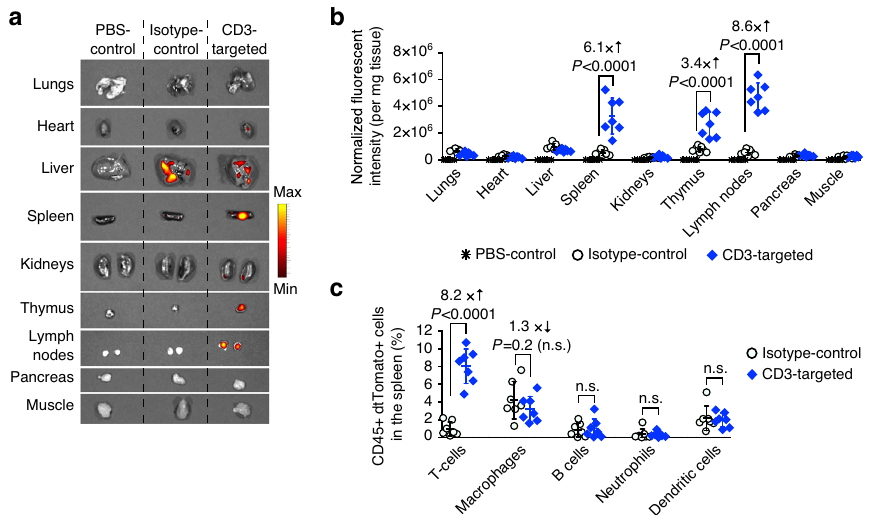
Fig. 5 Ef fi cient T-cell targeting in immunocompetent mice. B6.Cg-Gt(ROSA)26Sortm14(CAG-tdTomato)Hze/J (Ai reporter) mice were injected intravenously with three daily doses of nanoparticles loaded with 15 μ g mRNA encoding nuclear localization signal (NLS)-Cre. Nanoparticles were targeted to mouse T cells using a full-length anti-CD3 MuIgG2a, or IgG2a isotype control. Both antibodies were designed as LALAPG variants to ablate Fc receptor binding and complement activation. Forty-eight hours after the fi nal injection, organs were collected and whole-organ dtTomato fl uorescence was measured using fl uorescent IVIS imaging. Single cell suspensions of spleens and blood were labeled with antibodies against various immune cell subtypes and analyzed by fl ow cytometry. a Representative ( N = 7, 1 pictured) dtTomato expression in organs under fl uorescent IVIS imaging. b Quanti fi cation of fl uorescent signal in each organ. Each symbol indicates one measured organ. Horizontal lines indicate mean values, and error bars represent standard deviation of the mean. Pairwise differences in fl uorescent intensities between the groups were statistically analyzed by two tailed unpaired Student ’ s t -test. N = 7 biologically independent samples pooled from two independent experiments. c Graph displaying the mean ± SD percent of immune CD45 + dtTomato + cell types in the spleen. Macrophages (CD45 + , CD11b + , MHCII + , CD11c − , Ly6C − /low, Ly6G − ), B cells (CD45 + , B220 + ), T cells [CD4 + T cells (CD45 + , TCR- β chain + , CD4 + , CD8-), CD8 + T cells (CD45 + , TCR- β chain + , CD4 − , CD8 + )], neutrophils (CD45 + , CD11b + , MHCII + , CD11c − , Ly6G + ), and dendritic cells (CD45 + , CD11c + , CD11b − , MHCII + ) were measured. Each symbol indicates one mouse. Horizontal lines indicate mean values, and error bars represent standard deviation of the mean. Pairwise differences in fl uorescent intensities between the groups were statistically analyzed by two tailed unpaired Student ’ s t -test. N = 7 biologically independent